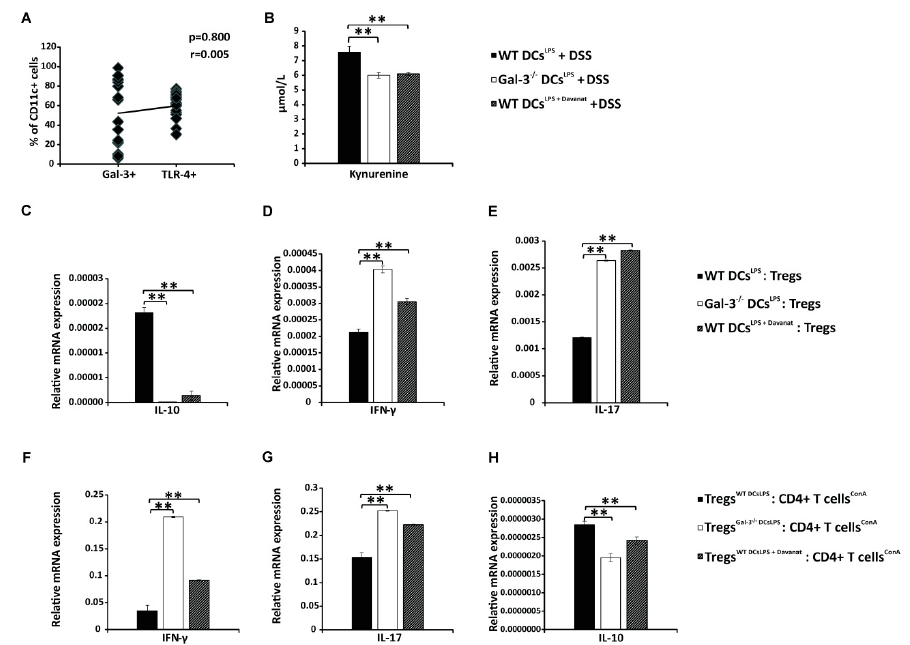
Figure 5. Gal-3 is required for optimal TLR-4-dependent production of KYN in DCs. Correlation between expression of Gal-3 and TLR-4 on colon-infiltrated CD11c+DCs 28 days after initial DSS administration ( A ). KYN production in LPS-primed DCs ( B ). Expression of IL-10, IFN- γ and IL-17